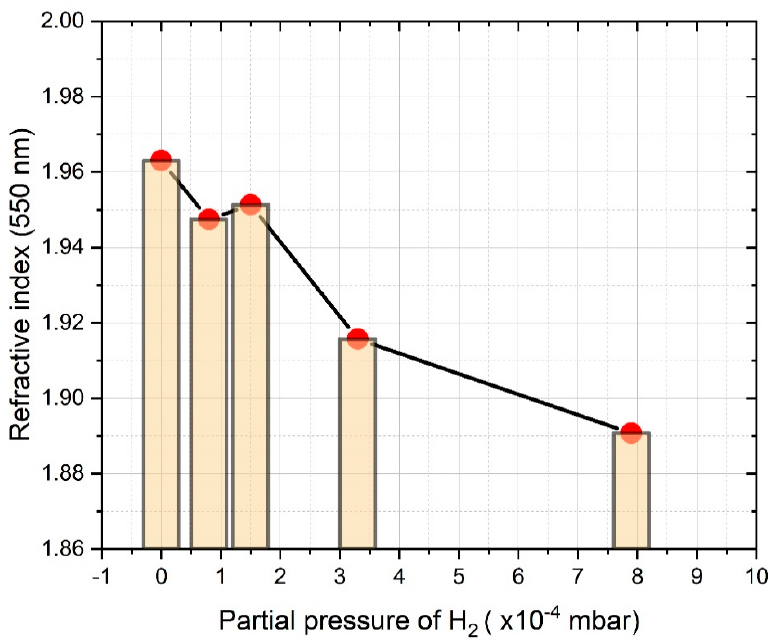
Figure 5. Refractive index at 550 nm against H 2 partial pressure.